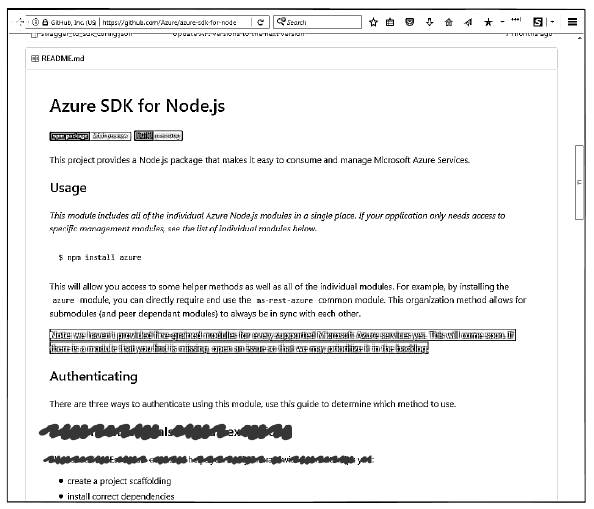
Fig. 14. List of supported AWS services (and specific API version) of the provided Node.js SDK.